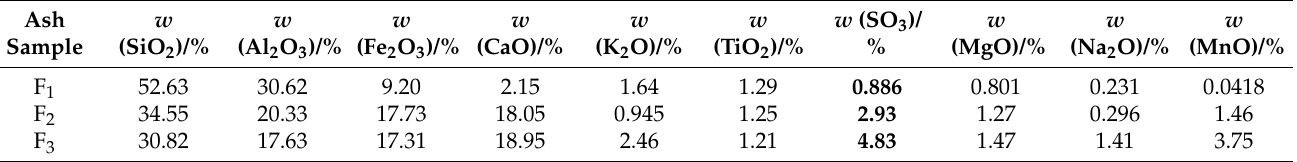
Table 5. XRF analysis on coal